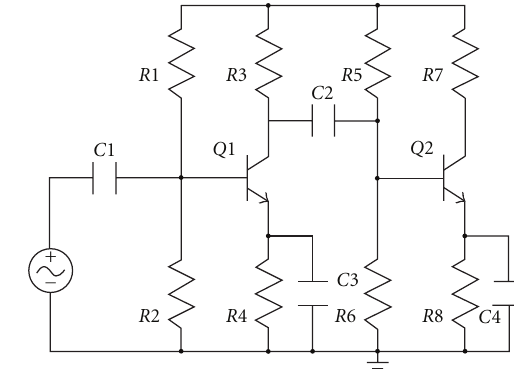
Figure 5: Two-stage bipolar amplifier.